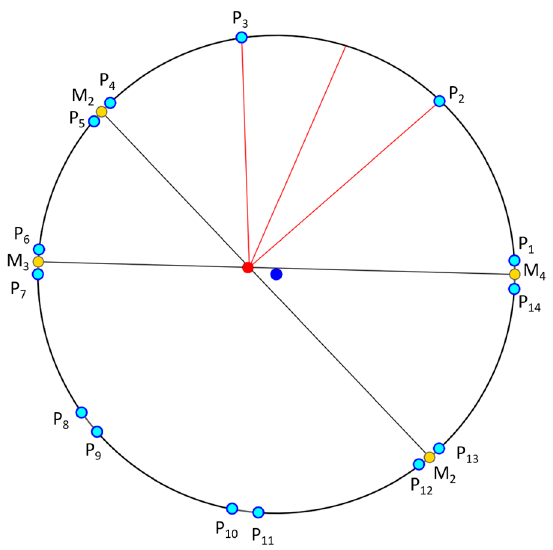
Figure 6. Our profile checker algorithm used to find the accurate center of the marker. Dark blue point is the incorrect center detected by the ATM algorithm, and the red point is the correct one detected by the profile checker algorithm.